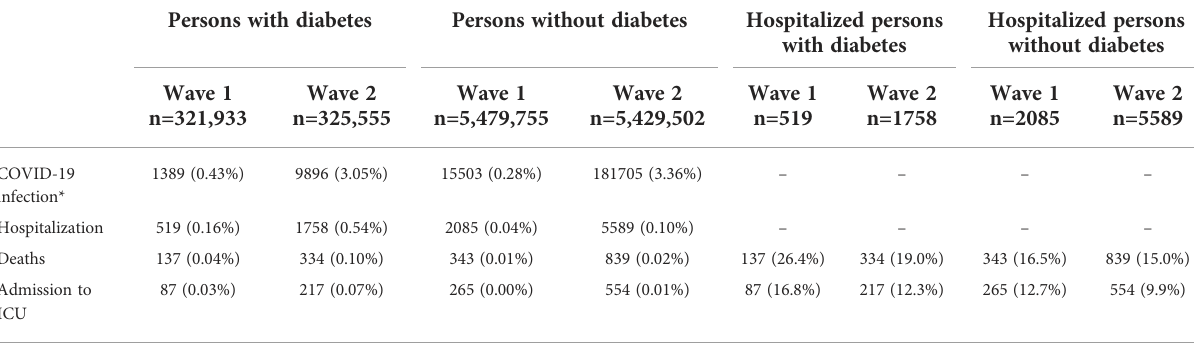
TABLE 2 Number of persons with COVID-19 infection, COVID-19 related hospitalization, death and intensive unit care (ICU) admission in the fi rst and second wave of the pandemic, strati fi ed by diabetes